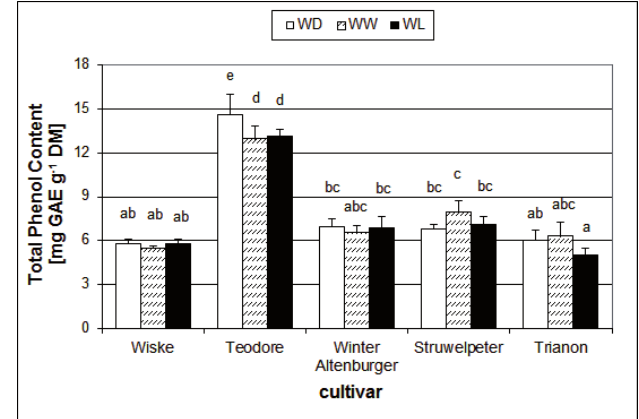
Fig. 3: Chlorophyll content [mg g -1 DM] of different cultivars and varieties of Lactuca sativa spp. grown under different water regimes (water- deficit = 18-25 % [WD], well-watered = 50 % [WW], water-logged = 61-70 % [WL]). Data represent n ± SD. Bars with different letters were significantly different (Dunett’s T3 test, p ≤ 0.05).